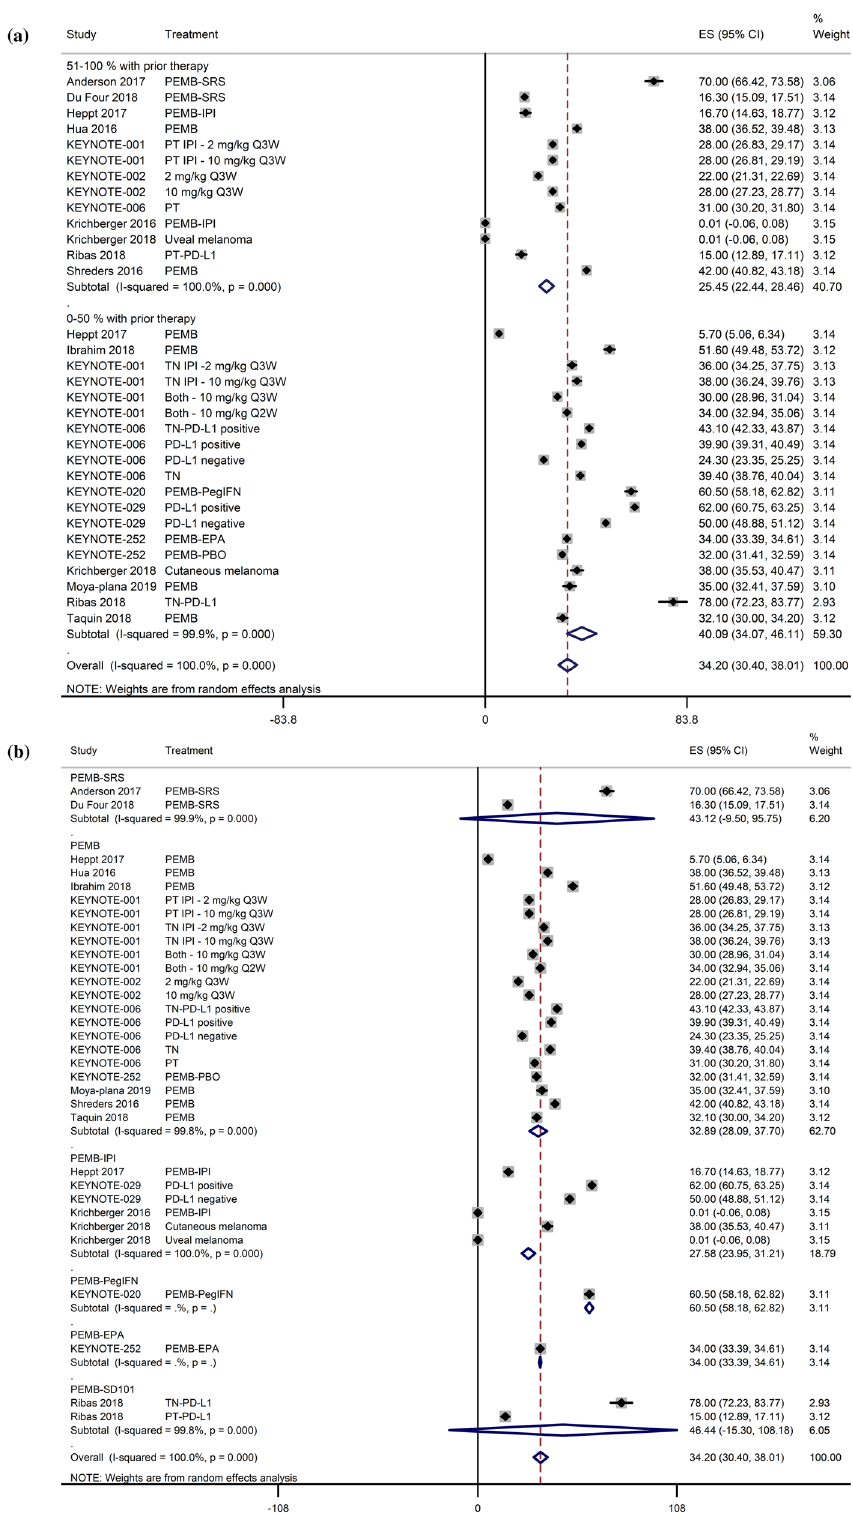
Figure 2: ( a ) A forest graph showing the pooled e ff ect sizes of ORR ( ES; e ff ect size with 95% CI ) with regards to the percentage of patients with prior therapy. ( b ) A forest graph showing the pooled e ff ect sizes of ORR ( ES; e ff ect size with 95% CI ) with regards to the combination of pembrolizumab